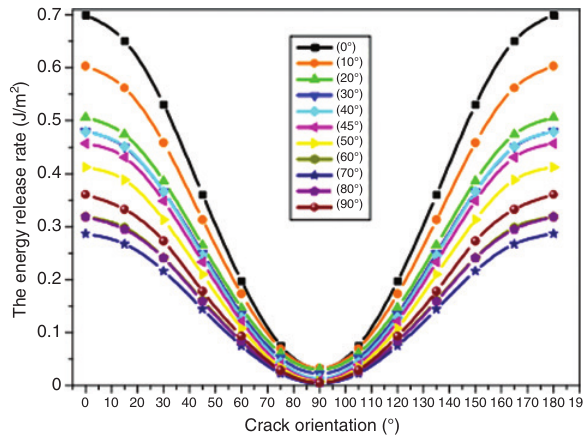
Figure 9: Variation of the energy release rate in function of the orientation of the cracks for all orientations of the fibers where the two circular notches are horizontal.